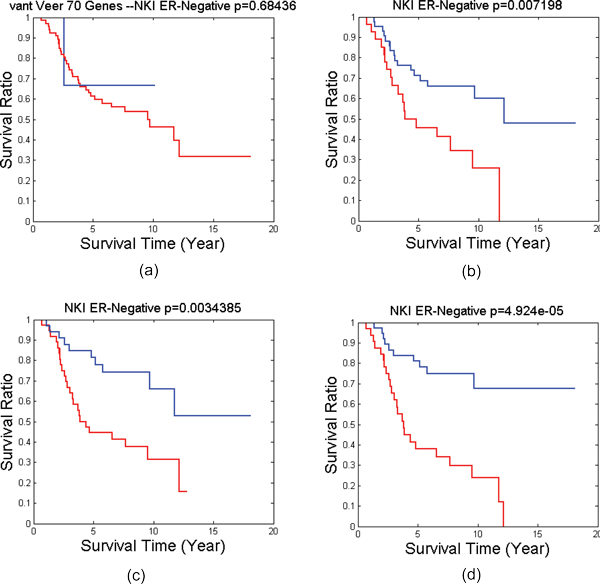
Survival tests on NKI ER-Negative. The survival test on NKI ER-Negative patients using (a) well-established 70-gene signature from [32], (b) Genes in BiNet 52 "C11orf51, DAP, EBP, HOMER2, LOC100129361, MAGT1, NDUFS6, NUDT21, PEX3, SDHA, SLC3A2", (c) Genes in BiNet 228 "C4BPB, CCR10, CKM, CPS1, CYP2F1, GPR6, GUCY1A2, HAUS6, HPD, HYAL1, PGAM2, PLA1A, PPP1R14D, PROC, REC8, SERPINA6, SFTPA2, STXBP5L, SYNPO2L, TGFB2, TPTE, VASH2", (d) the union of gene lists (b) and (c) plus gene UBC. Blue lines are the survival curves of good survival groups. Red lines are the survival curves of poor survival groups.